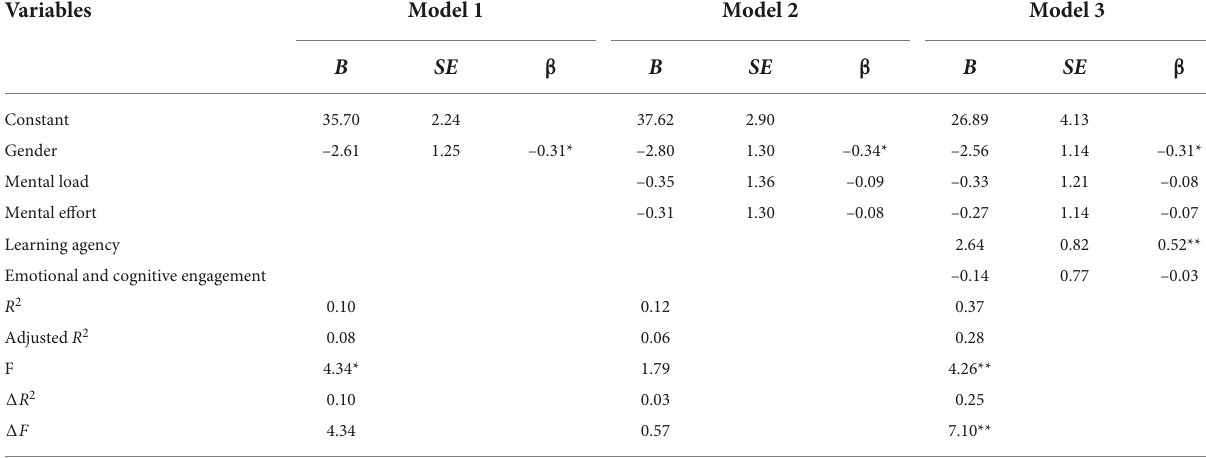
TABLE 3 Hierarchical regression analysis for HLC with the total score as the independent variable ( N = 42).